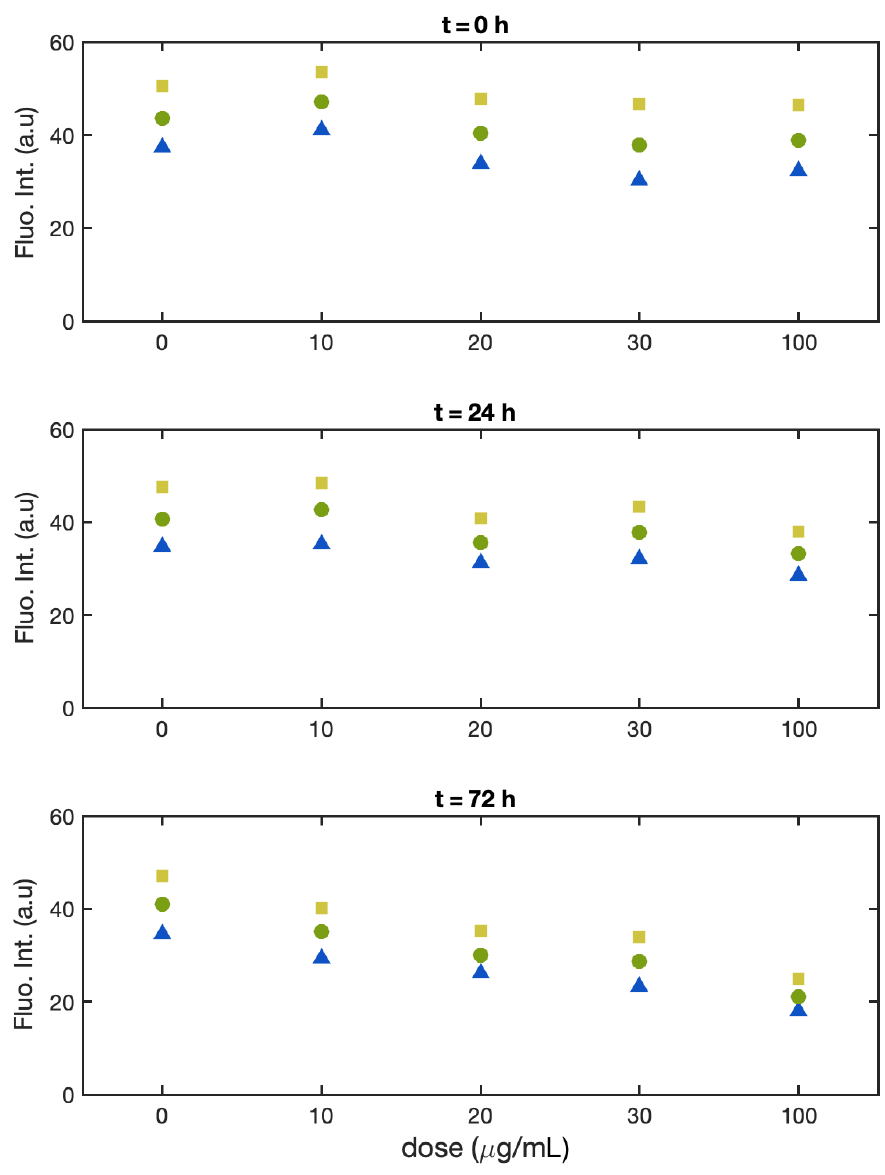
Figure 4. Batch 2: Normalized fluorescence intensity of the single alga cells at the 25th percentile (yellow square), median (green dot), and 75th percentile (blue triangle) as a function of Cu(II) concentration at t = 0 ( upper panel ), t = 24 h ( middle panel ), and t = 72 h ( lower panel ).